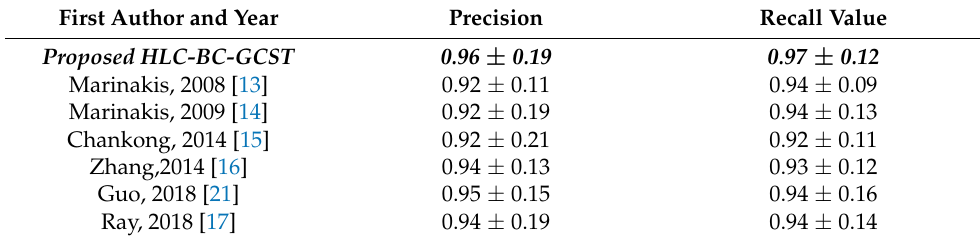
Table 3. Comparative Performance: Precision and Recall